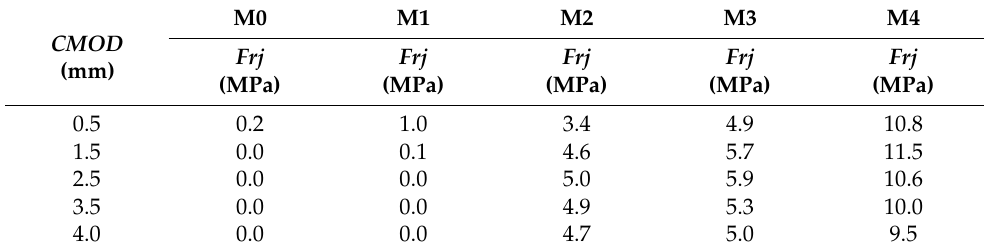
Table 3. The mean residual flexural tensile strength corresponding with CMOD .